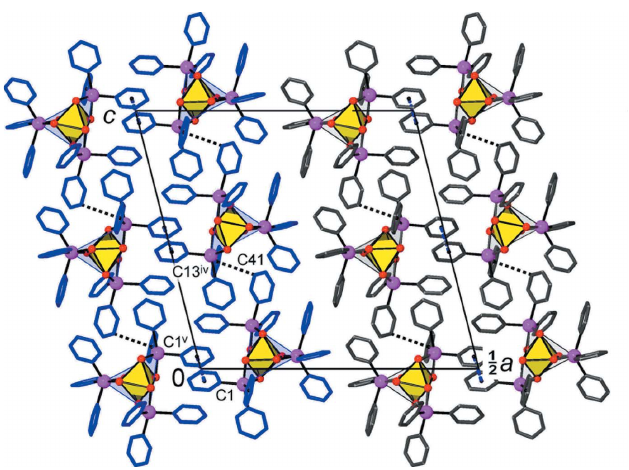
Figure 4 Crystal packing of the title compound, viewed down the b axis, showing how the C—H (cid:2)(cid:2)(cid:2) O bonded chains (which are orthogonal to the drawing plane) are connected into layers by means of C–H (cid:2)(cid:2)(cid:2) (cid:4) and slipped (cid:4) – (cid:4) stacking interactions. The blue and grey colours indicate two separate bilayers, which lie parallel to the bc plane. [Symmetry codes: (iv) x , (cid:3) y + 1, z + 1 ; (v) (cid:3) x , (cid:3) y + 1, (cid:3) z .] 2